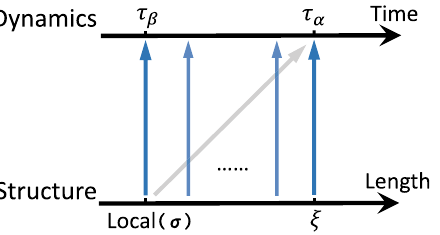
FIG. 3. Illustration of the nonlocal scenario of structure- dynamics correlation. Top: The glassy dynamics evolves with time and shows two characteristic timescales, the fast β ( τ β ) and α relaxation times ( τ α ). Bottom: The structure can be characterized by a static order parameter based on local configurations, which are intrinsically correlated over a characteristic length ξ . The nonlocal causal relation between structure and dynamics is represented by vertical arrows (blue), where the correspondences such as local structure σ → dynamics over τ β and ξ → τ α are highlighted. The previous approaches focusing on the correlation between local structure ( σ ) and α relaxation are indicated by the inclined arrow correlation. The values of the peak correlation C and the r;p corresponding L are plotted as functions of time t in p Figs. 4(b) and 4(e) for 2D polydisperse and binary systems, respectively, and Fig. 4(h) for the 3D binary system.